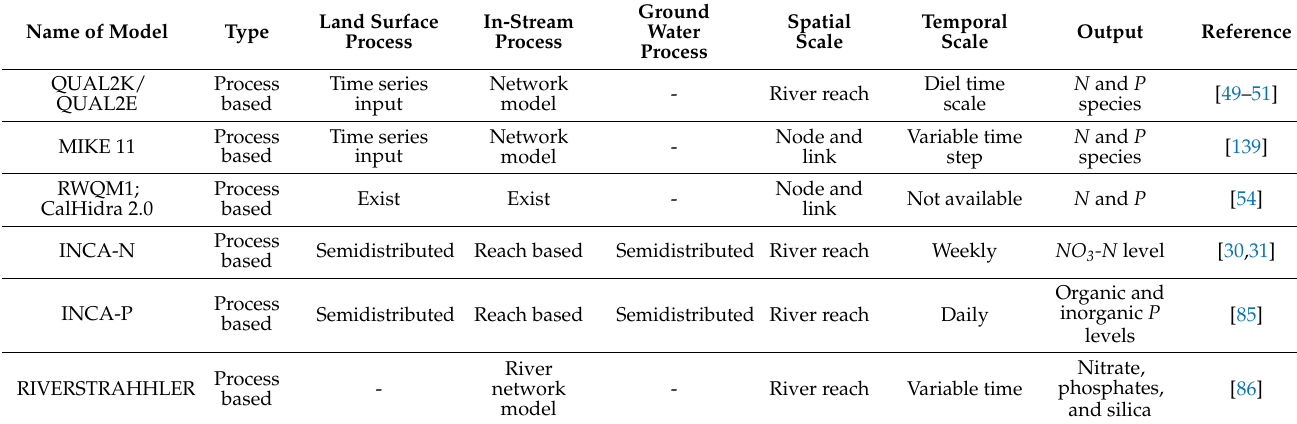
Table A2. The summary of river water quality models.